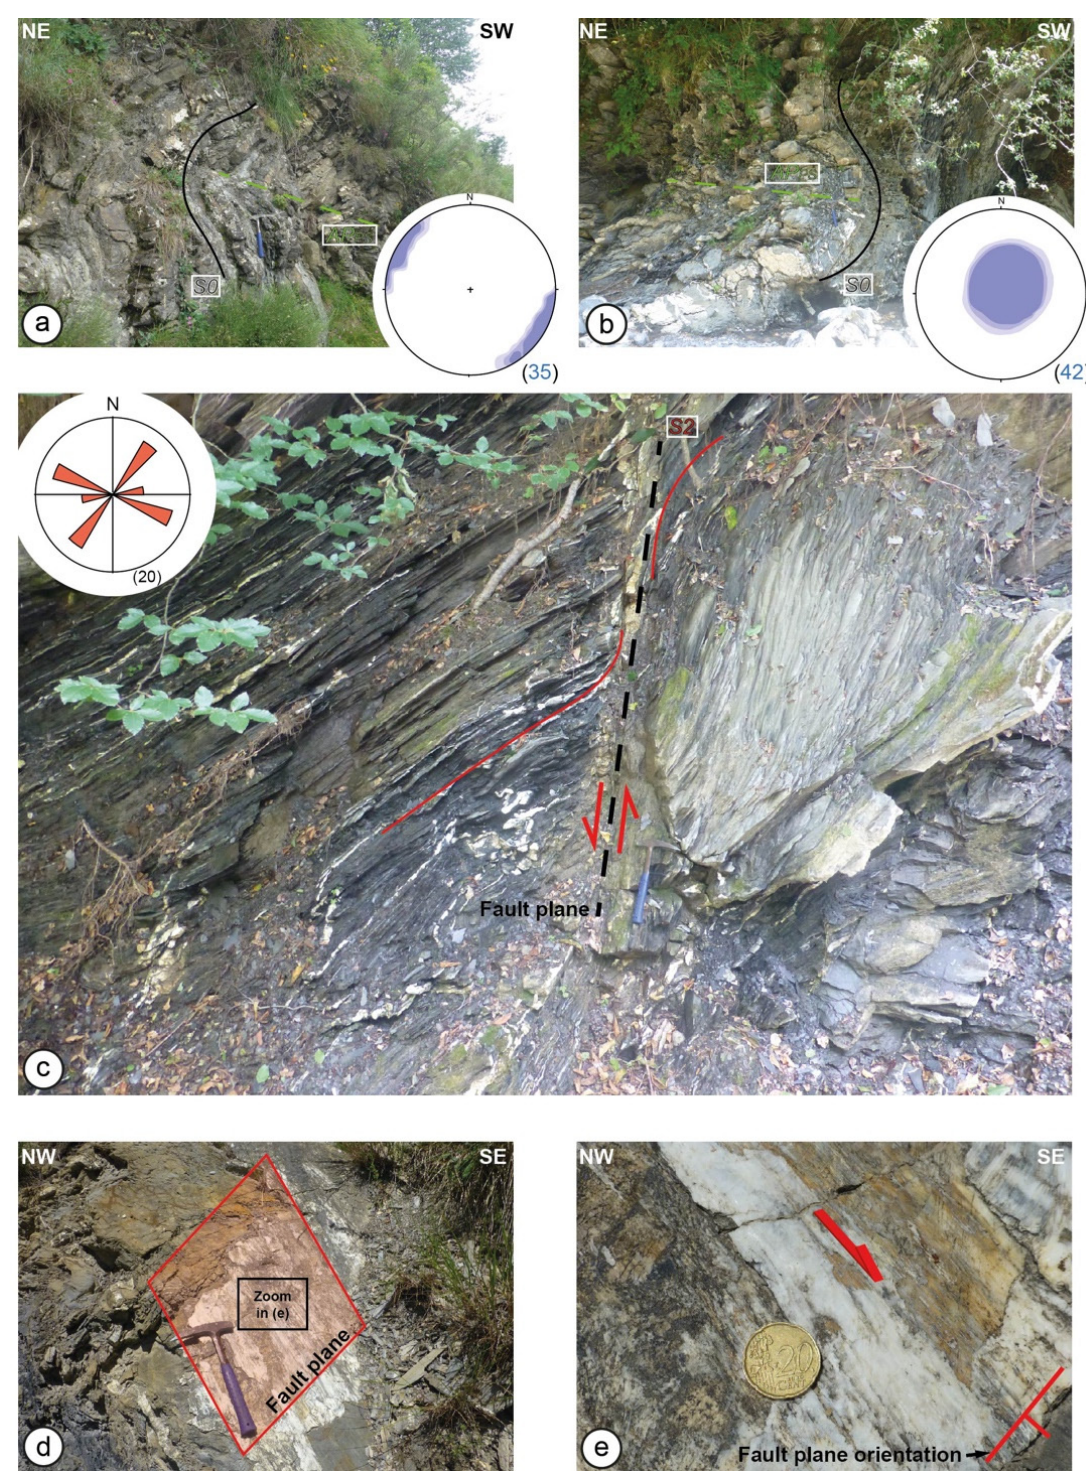
Figure 8. ( a , b ) Outcrop-scale post-coupling folds; on the bottom right the stereoplots of the related linear and planar structural features are shown; ( c ) Fault plane trace (black dashed lines) cutting the S2 foliation (red lines), Pieve di Teco Formation outcrop. The red arrows indicate the sense of movement. On the top left, the geometrical distribution of the fault planes is shown; ( d ) Mesoscale fault plane with striae; ( e ) Close-up of the fault plane of ( d ). The red arrows indicate the sense of displacement. S0: bedding; AP PS : axial plane trace of post-coupling fold system.